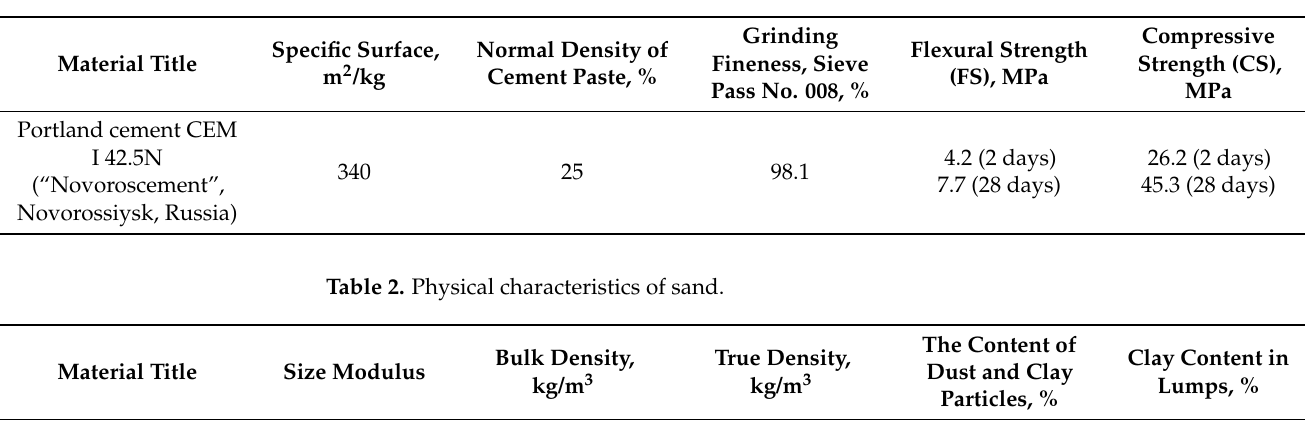
Table 1. Properties of cement.